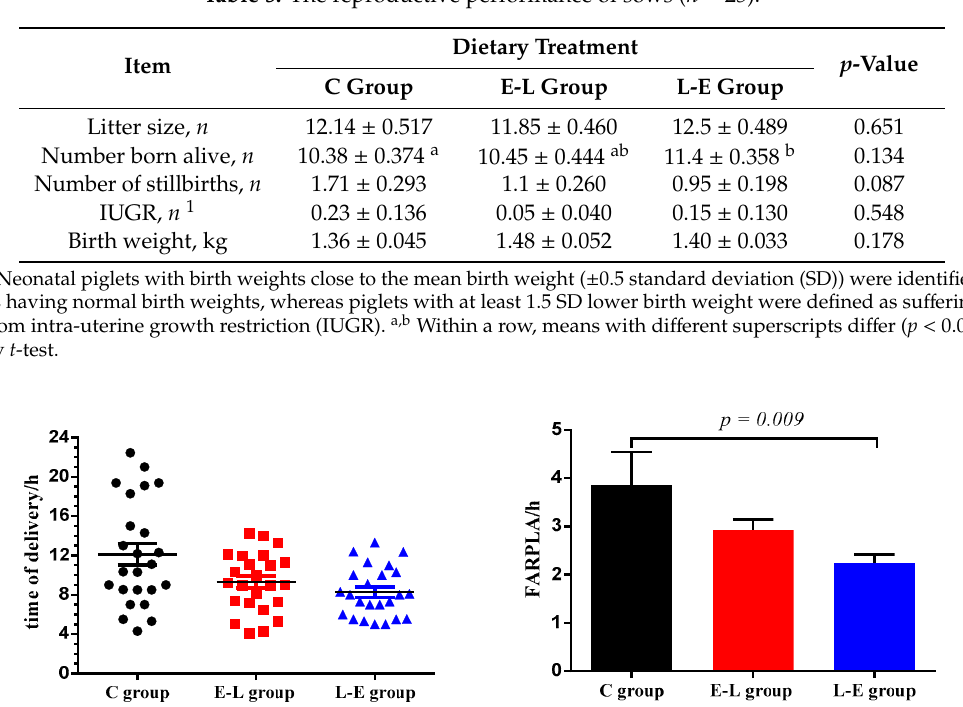
Table 6. Growth performance of suckling piglets ( n =